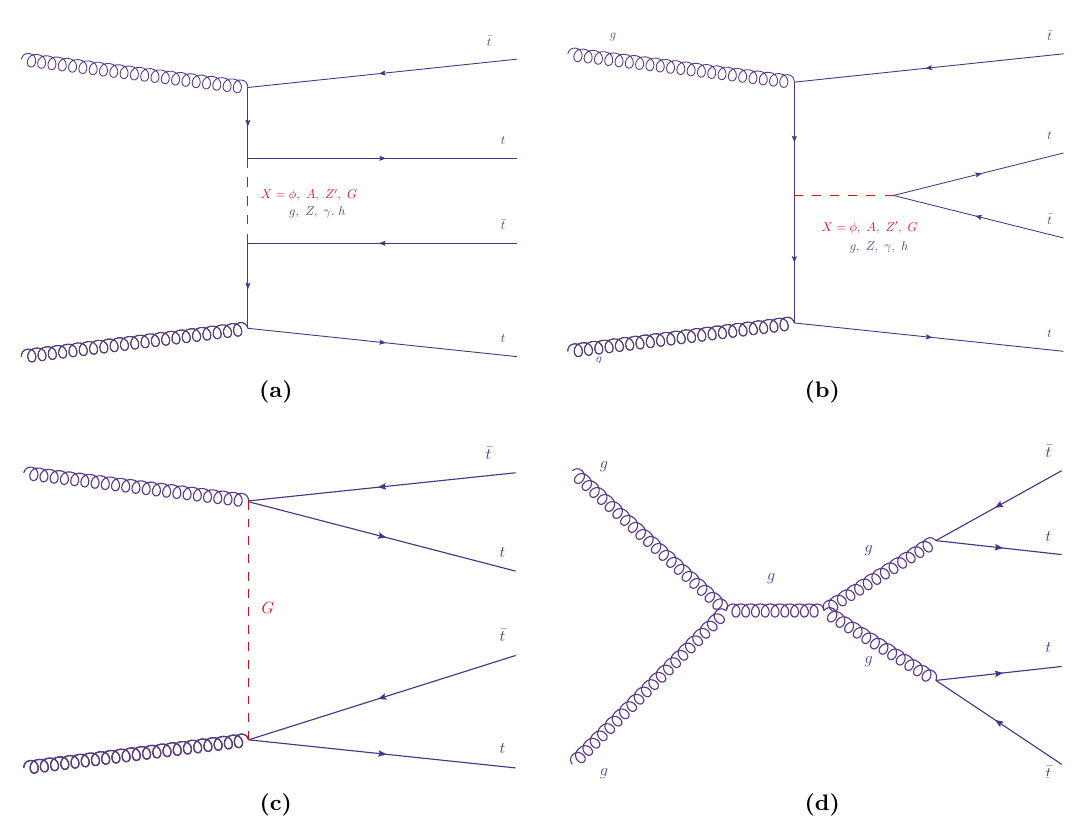
Figure 1. Representative Feynman diagrams for the pp t (cid:22) tt (cid:22) t process at the LHC where, at ! p s = 13 TeV, approximately 90% of the production cross-section is through gluon fusion. In (a) and (b) the dashed line may correspond to any of the NP particles considered in this work ( (cid:30) , A , Z 0 or G ), in addition to the SM particles ( g; Z; (cid:13) and Higgs). Diagram (c) is only allowed in the spin-2 NP model, where the 4-point interaction is required to ensure gauge invariance. Diagram (d) correspond to a typical QCD SM diagram. Diagrams (a) and (c) are important for not having s - channel suppression. In particular, in diagram (c) the Graviton model provides four-top production through only 2 vertices without s -channel suppression and with all four top quarks on an equal footing, which provides distinctive features (see text for